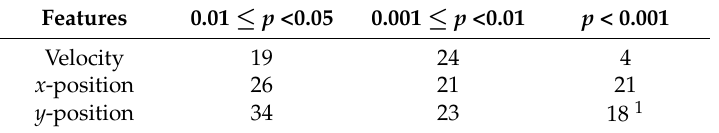
Table 2. P-values comparing fixed- and growth-mindset